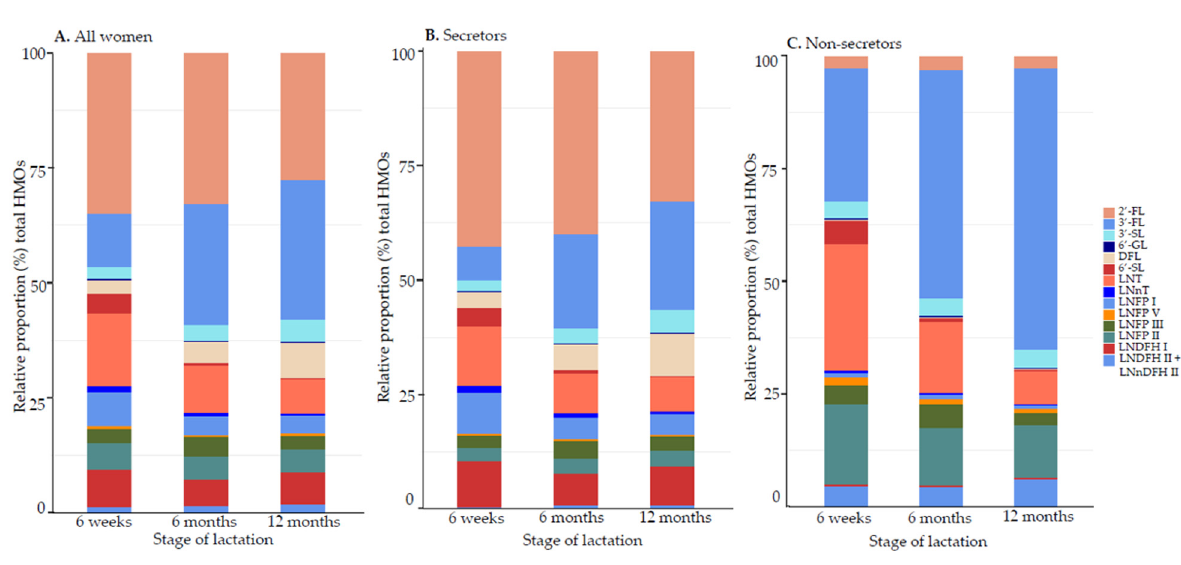
Figure 2. Relative proportion (%) of human milk oligosaccharides (HMOs) in human milk samples collected at 6 weeks, 6 months, and 12 months. Percentages of total HMOs were calculated for ( A ) all women regardless of milk group or secretor status; ( B ) secretor milks attributed to milk groups I and III; and ( C ) non-secretor milks attributed to milk groups II and